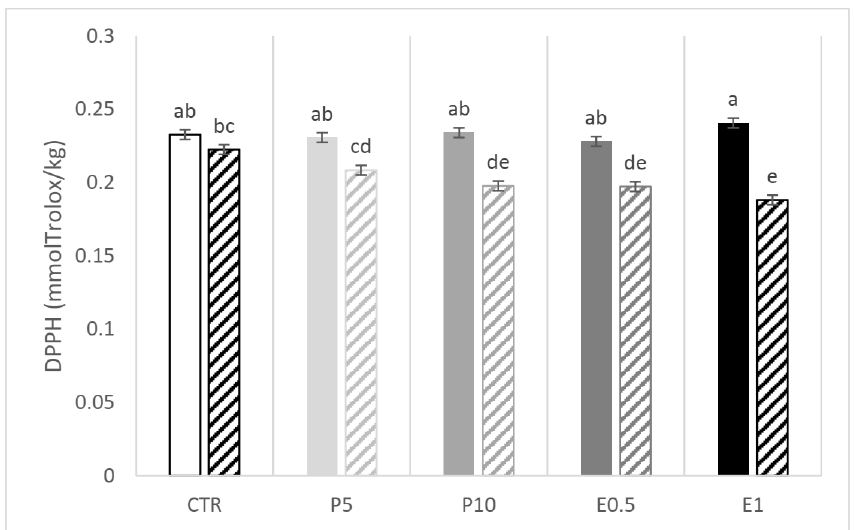
Figure 3. DPPH value of fillets from fish fed the CTR: control diet without HBP and HBP_SFE (white bars); P5 (light grey bars) and P10 (grey bars): diets including 5% or 10% of honeybee pollen (HBP), respectively; E0.5 (dark grey bars) and E1 (dark bars): diets including 0.5% or 1% of supercritical fluid extract (SFE) of HBP (HBP_SFE), respectively. Full colored bars are for samples analyzed at day 0, while crossed bars are for samples analyzed at day 110. The letters a, b, c, d, e indicate statistically different means according to the significant T × S interaction ( p <